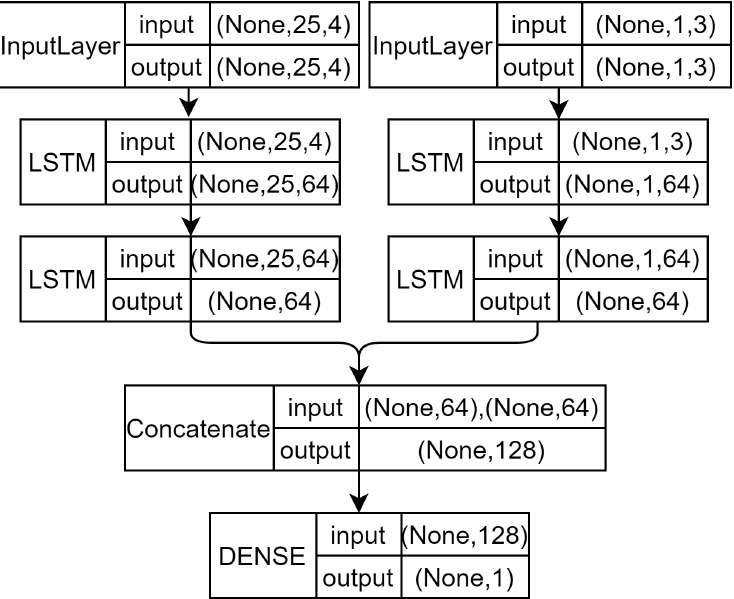
Figure A7. Aiello’s architecture block